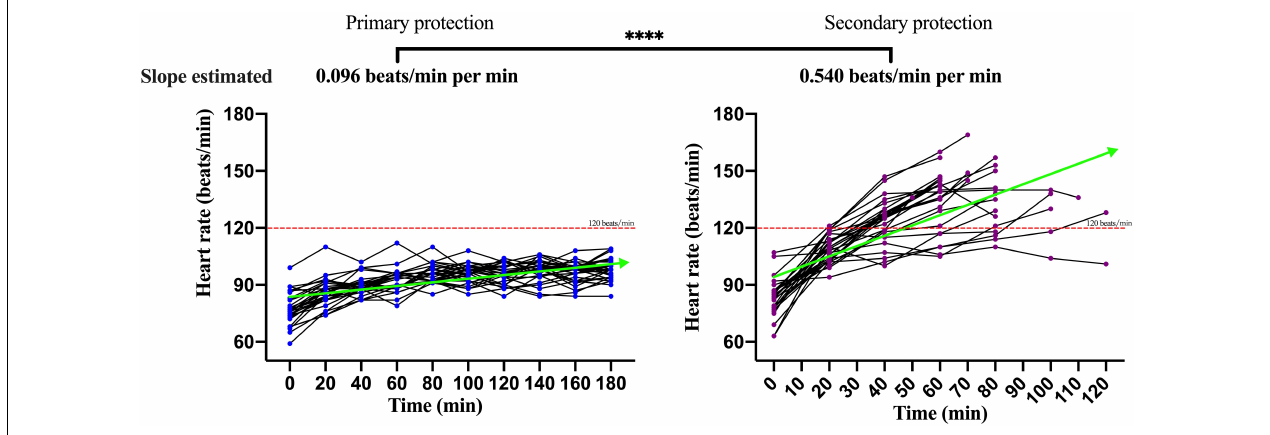
FIGURE 2 | The dynamics of heart rate of participants wearing primary PPE and secondary PPE. ∗∗∗∗ p < 0.0001. The slopes of heart rate during the trial were calculated by generalized estimating equations. PPE, personal protective equipment.